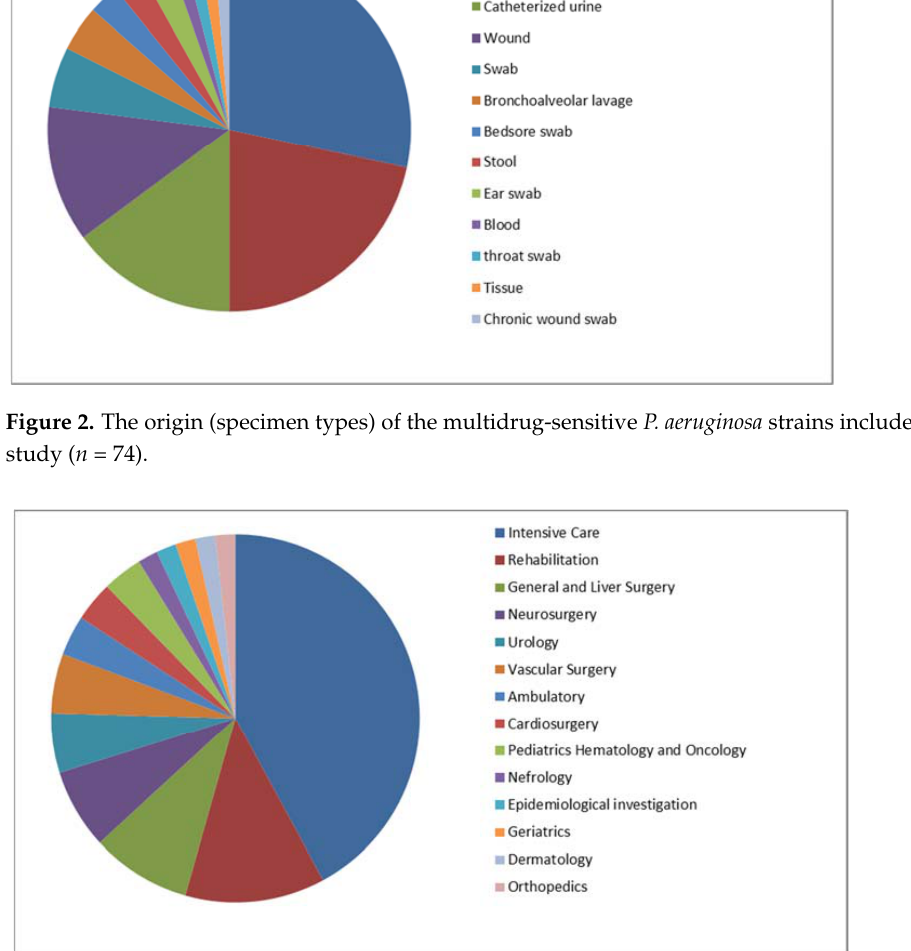
Figure 4. The origins (specimen types) of the multidrug ‐ resistant P. aeruginosa strains included in the study ( n = 57). There was a statistically significant relationship between the frequency of the lasB ( p = 0.0354), plC N ( p = 0.0051) and plC H ( p = 0.0227) genes and their occurrence among the MDR isolates. In the group of MDR strains, the only moderate positive correlation observed was that of the pilA and pilB genes (r = 0.5669). In the group of MDS strains, the only moderate positive correlation observed was that of the plC H and lasB genes (r = 0.6752), and a weak positive relationship between the plC H and plC N gene was noted (r = 0.2849). In the present study, the only negative correlation between the genes, in terms of their presence, was noted among the MDS strains (r = − 0.2327, weak) in the case of the exoU and pilA genes. The detailed statistical calculation of Spearman’s rank correlation coefficient for the particular gene pairs, with respect to the antimicrobial susceptibility profiles of the P. aeruginosa strains included in the study, is presented in Supplementary Materials, Table S3.